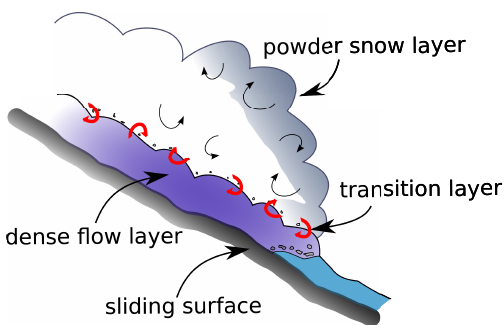
Fig. 1. Avalanche layer structure assumed in the SamosAT model. The dense core of the snow avalanche flows on the sliding surface. Snow particles are exchanged in the resuspension transition layer to enter the powder snow